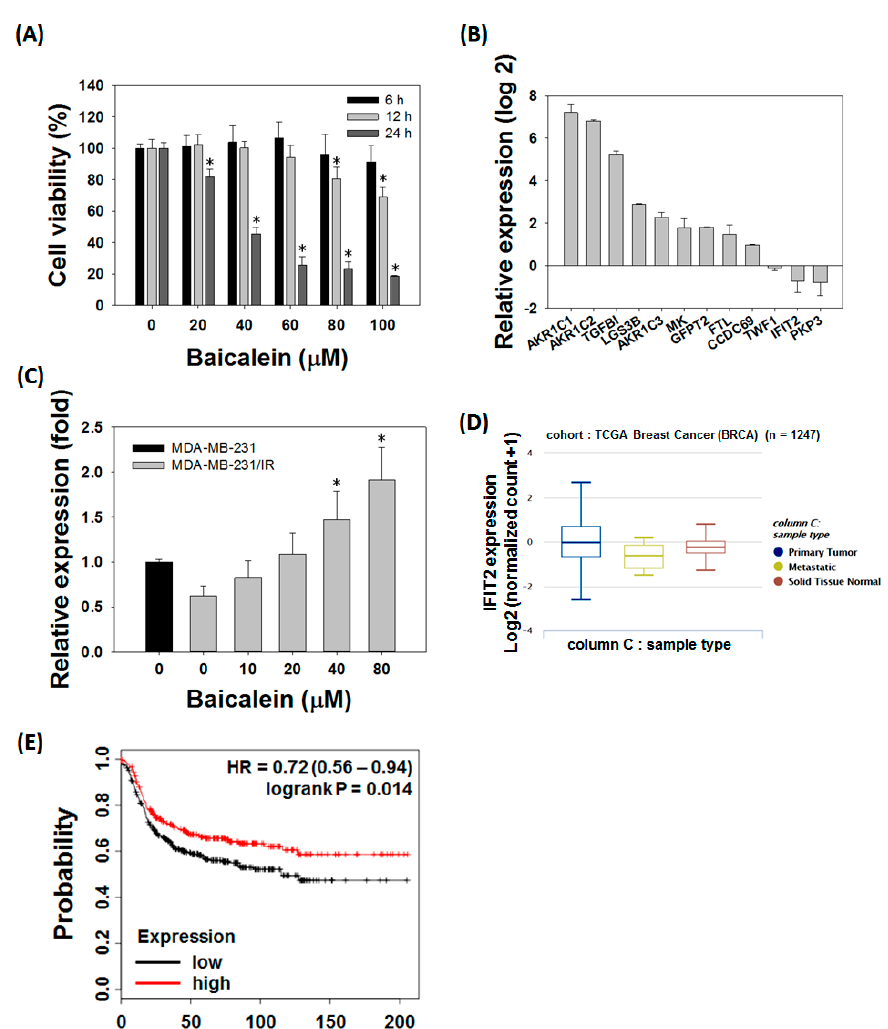
Figure 4. Baicalein treatment reversed levels of IFIT2, which is known to be associated with metastasis and recurrence. ( A ) MTT assay of baicalein on MDA-MB-231/IR cells for 6, 12, and 24 h. ( B ) Expression levels of DEGs involved in resistance in MDA-MB-231/IR cells. ( C ) IFIT2 gene expression after baicalein treatment for 24 h. ( D ) IFIT2 expression in primary tumor, metastatic, and solid normal tissue of breast cancer patients based on Xena browser. ( E ) Relapse-free survival (RFS) plot of TNBC patients analyzed by IFIT2 expression with the Kaplan–Meier plotter. Asterisks (*) indicate significant differences at p < 0.05.